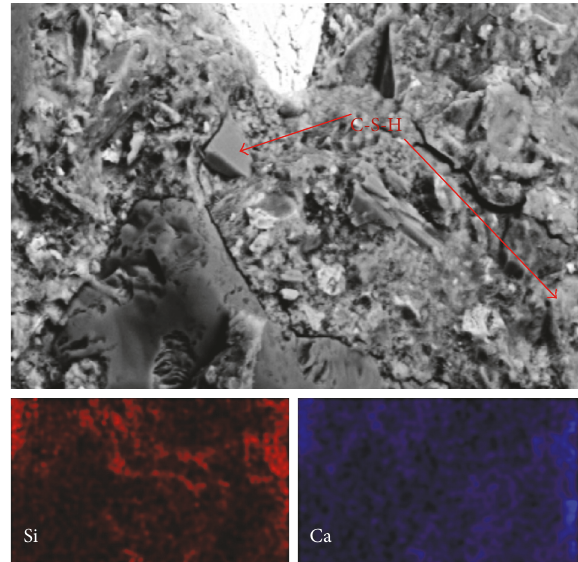
Figure 7: SEM image and its EDAX mapping on Si, Mg, and Ca of control specimen (CS).